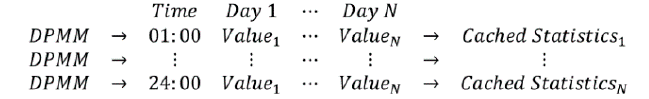
Figure 6. Proposed implementation of Dirichlet Process Mixture Model (DPMM).